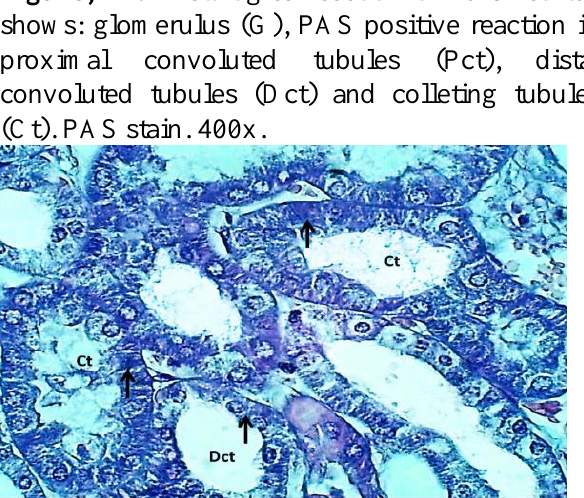
Figure, 13: Histological section of renal cortex shows: positive Alcian blue reaction (arrows) in distal convoluted tubules (Dct) and colleting tubules (Ct). Alcian blue stain.